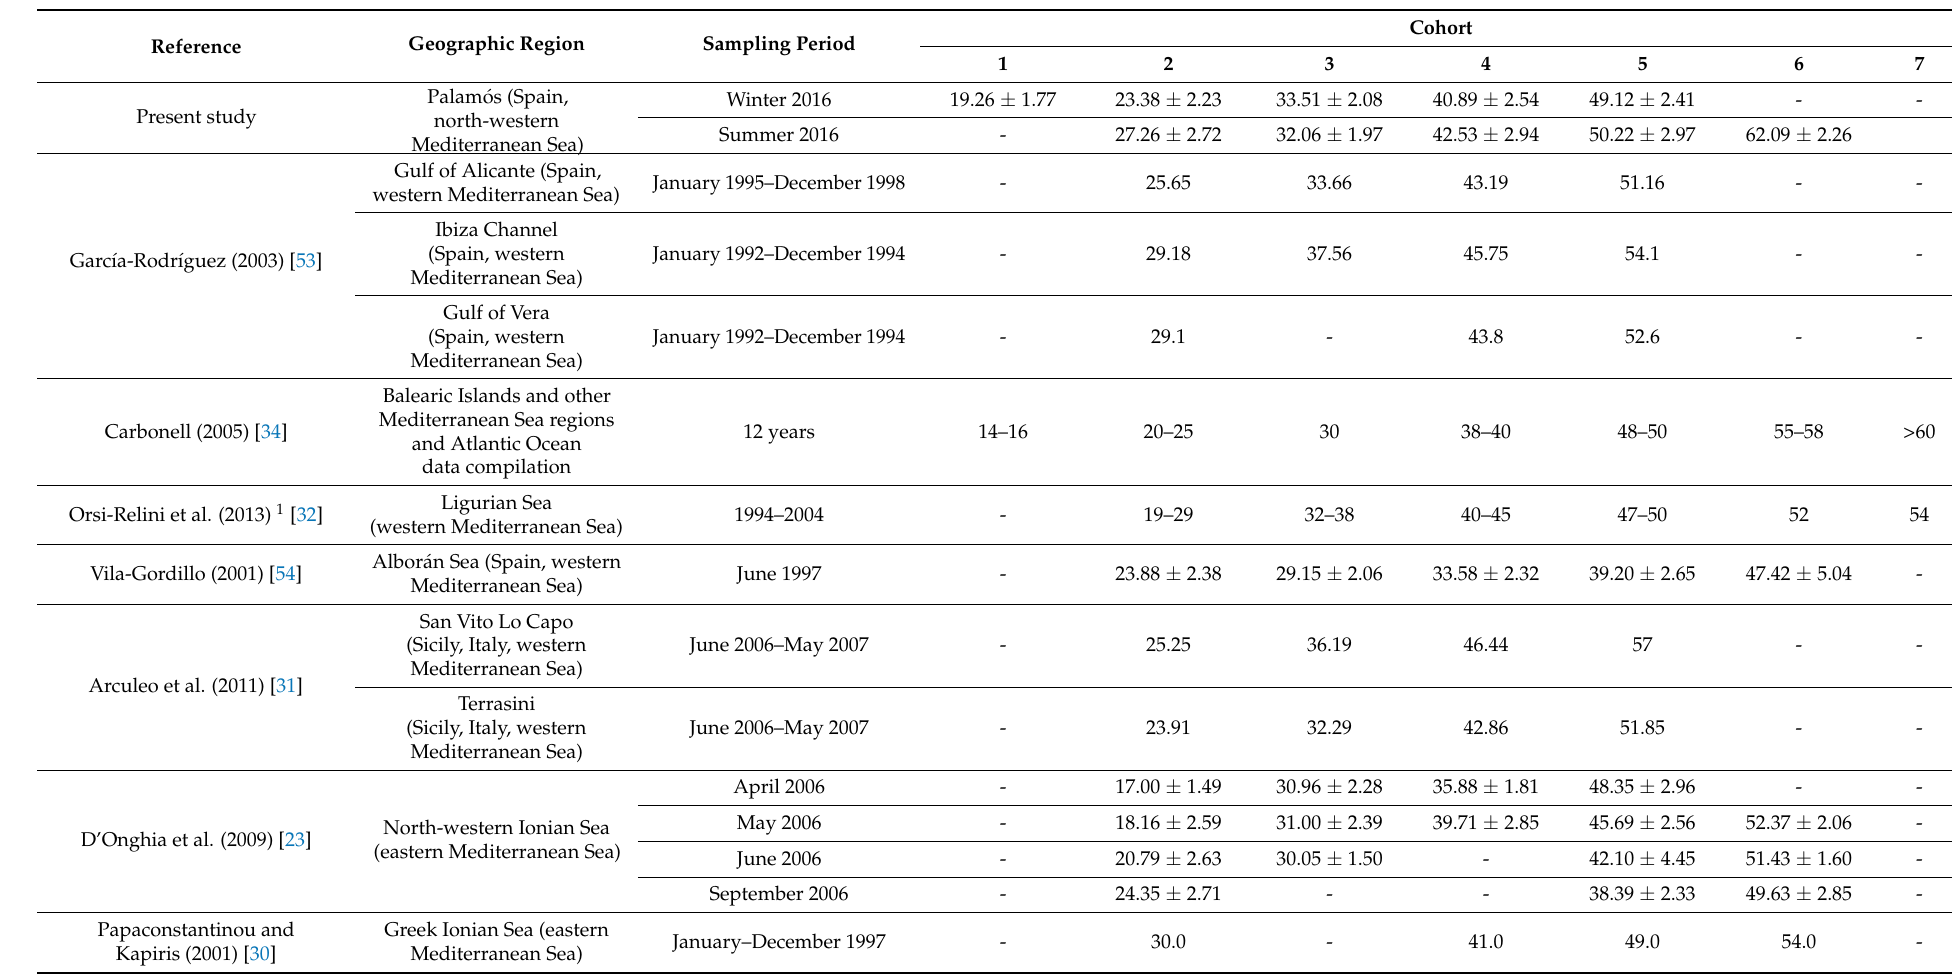
1 Data corresponds to the pooled data (MEDITS plus GRUND trawl